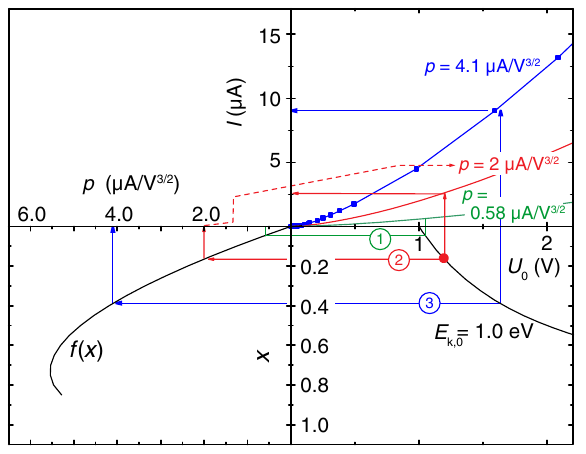
FIG. 7. Working diagram of the beam deceleration scheme. In the lower right diagram a space-charge parameter x is chosen on the curve for a desired axial kinetic energy. Three cases are indicated: 1 (green): extracted current corresponding to the electron-gun perveance, using U 0 as the extraction voltage. The beam current (read from the perveance law in the upper right diagram) is < 1 μ A. 2 (red): Higher extraction voltage is used at the electron gun; the extraction voltage (higher than U 0 ) is set to obtain an electron current of ∼ 2 . 5 μ A and for deceleration, U 0 is adjusted to ∼ 1 . 2 V as shown on the line intersecting the right abscissa. 3 (blue): Experimental maximum, for a beam current set to ∼ 8 . 5 μ A, a space-charge parameter near the limit x is reached b for this E and U 0 must be set to ∼ 1 . 7 k; 0